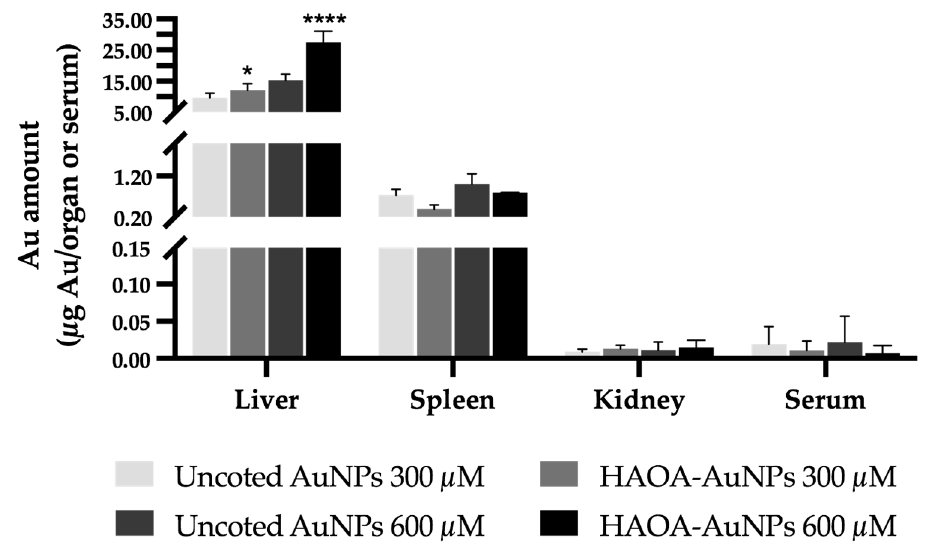
Figure 9. Gold content in terms of µg of Au/organ or serum in the liver, spleen, kidney and serum of Balb/c mice 24 h post-i.v. administration of uncoated and HAOA-coated AuNPs at 300 and 600 µM. Determination of the gold content was performed by ICP-OES. Data are presented as mean value ± SEM, n = 3. Two-way analysis of variance (ANOVA), Tukey’s test ( p < 0.05), were used to detect differences between the groups. * p < 0.0332 and **** p < 0.0001 vs. uncoated AuNPs at the same concentration.